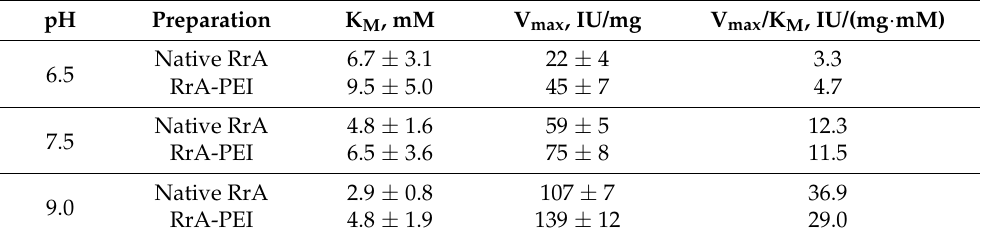
Table 4. K М and V max values for native RrA and PEC–RrA-PEI within a pH range of 6.5–9.0 in a 5 mM citrate–phosphate–borate buffer.